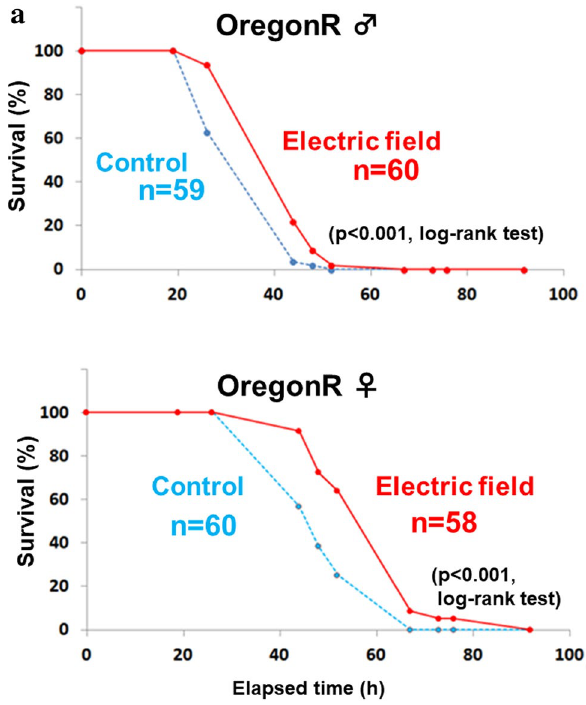
Figure 3. Effects of EF on lifespan of wild type and cry gene mutant Drosophila melanogaster under starvation. ( a ) The average lifespan of wild type flies (Oregon R) with both of sex was ~ 20% prolonged significantly by 50 Hz EF exposure that started at 2–3 days after eclosion. Starvation was in 1% agarose (that maintained humidity). Upper panel shows the survival curves of male EF exposed flies (n = 60) and male shame controlled flies (n = 59). p < 0.001, log-rank test. Lower panel shows the survival curves of female EF exposed flies (n = 58) and female shame control flies (n = 60). p < 0.001, log-rank test. This experiment was repeated 33 times for male, 3 times for female. ( b ) Lifespan was not significantly elongated in all three types of cry mutants. Each panels show survival curves for cry mutant flies with EF exposure experiment under starvation. Upper left panel, cry b male (p = 0.29, log-rank test). Lower left panel, cry b female (p = 0.23, log-rank test). Upper right panel, cry 01 male (p = 0.76, log-rank test). Lower right panel, cry 03 male (p = 0.84, log-rank test). This experiment was repeated 26 times for cry b male, 4 times for cry b female, 6 times for cry 01 , 3 times for cry 03 . ( c ) Survival curves for GAL4/ UAS-driven RNAi system for knockdown of cry with EF exposure experiment under starvation. Upper panels show the parent lines. Left panel displays UAS-cry-RNAi (p < 0.01, log-rank test). EF exposed flies (n = 16) versus shame control flies (n = 15). Right panel displays elav-Gal4 (p < 0.01, log-rank test). EF exposed flies (n = 31) versus shame control flies (n = 34). Lower panel shows cry knock down with using GAL4/UAS-driven RNAi system (p = 0.87, log-rank test). EF exposed flies (n = 21) versus shame flies (n = 21). Exposure to EF significantly increased average lifespan of WT, but not of cry- deficient ( cry b , cry 01 , cry 03 and cry RNAi) lines. In contrast, the average lifespan of control cry RNAi parental strains was significantly increased. EF electric field, WT wild type. This experiment was repeated 5 times for UAS-cry-RNAi , 2 times for elav-Gal4 , 4 times for UAS-cry-RNAi ; elav- Gal4 . ( d ) GAL4/UAS- cry system rescued cry mutant flies from EF unsusceptibility in survival assay. UAS-cry and/or cry-Gal4 were introduced to endogenous cry mutated fly ( cry 01 ). Upper panels show survival curves for the parent lines. Upper left panel displays survival curve for cry-Gal4; cry 01 (p = 0.87, log-rank test). EF exposed flies (n = 25) versus shame flies (n = 26). Upper right panel displays survival curve for UAS-cry; cry 01 (p = 0.57, log-rank test). EF exposed flies (n = 33) versus shame flies (n = 33). Lower panel displays rescue flies, cry-Gal4/ UAS-cry; cry 01 (p < 0.0001, log-rank test). EF exposed flies (n = 45) versus shame flies (n = 46). This experiment was repeated 2 times for cry-Gal4; cry 01 , 8 times for UAS-cry; cry 01 , 2 times for cry-Gal4/UAS-cry; cry 01 . ( e ) EF exposure did not affect the survival of backcrossed cry b strains. To compare the effect of EF exposure on homogeneous genetic background flies, cry b strain backcrossed 7times with wild type (Canton S) was prepared. Right panel displays survival curve for Canton S (p < 0.05, log-rank test). EF exposed flies (n = 10) versus shame control flies (n = 10). Left panel displays the survival curve for cry b flies backcrossed with Canton S (p = 0.90, log- rank test). EF exposed flies (n = 10) versus shame flies (n = 16). This experiment was repeated 7 times for Canton S, 4 times for cry b , backcrossed with Canton